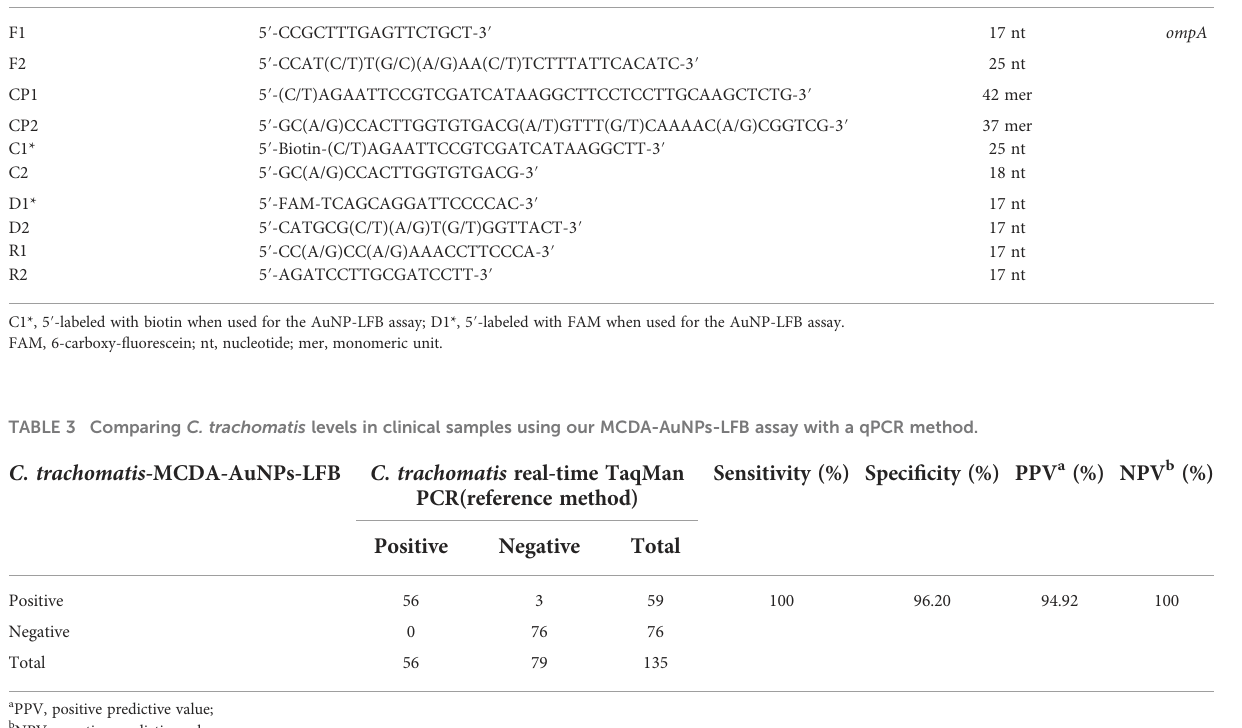
TABLE 2 C . trachomatis -MCDA-AuNPs-LFB degenerate primers used in this study. Primer name